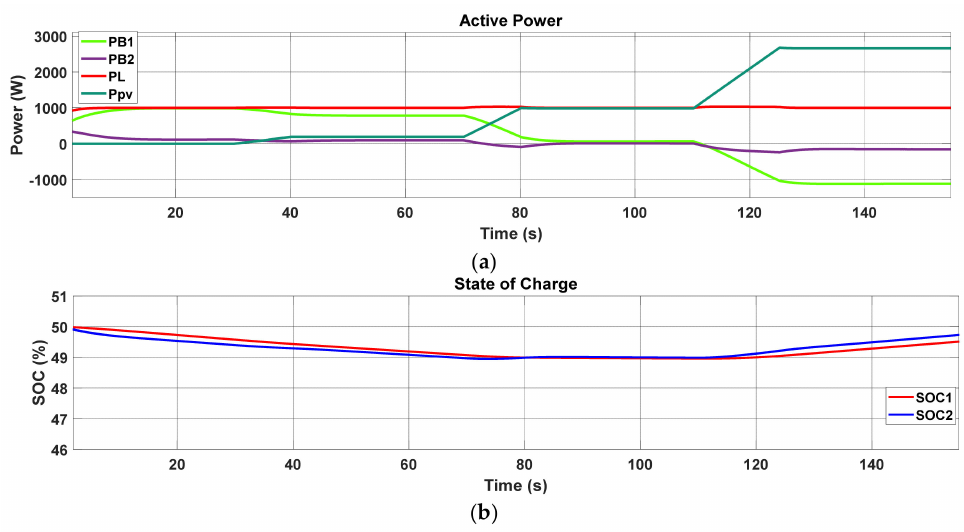
Figure 16. Distributed secondary control based on consensus algorithm, ( a ) system power sharing and ( b ) SOC in batteries 1 and 2 in a time of 155 s.